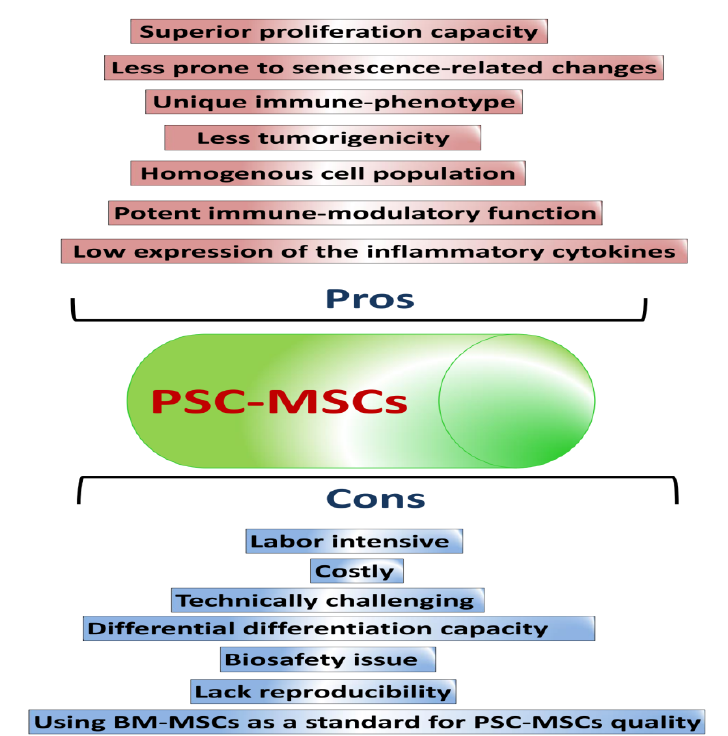
Figure 8. Representative diagram summarizing the pros and cons of PSC-MSCs.